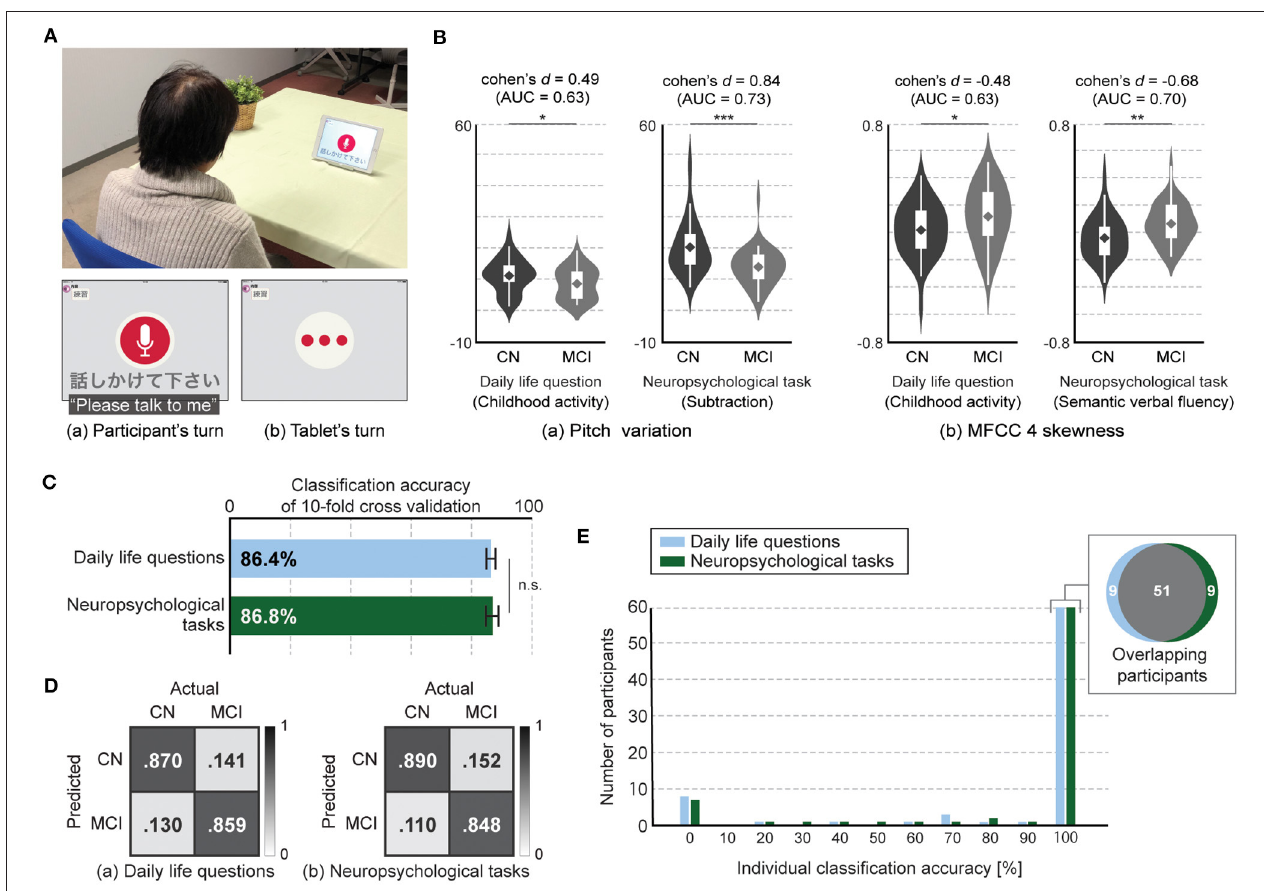
FIGURE 1 | Tablet-based assessment using speech responses to daily life questions and neuropsychological tasks. (A) Experiment setup and application interface. (B) Speech features with statistical significances between CN and MCI participants in both types, i.e., daily life questions and neuropsychological tasks, (two-tailed Student’s t -test with false discovery rate correction). Both speech features in responses to daily life questions had statistical significance but lower discriminative power between CN and MCI participants compared with those in responses to neuropsychological tasks. Significant differences are denoted with asterisks (* P < .05, ** P < .01, *** P < .001). Violin plot is used to visualize distribution of data and probability density. On each side of violin is kernel-density estimation to show distribution shape of data. Wider portion of violin indicates higher density and narrow region represents relatively lower density. White box with whiskers in violin is boxplot. Box denotes 25th (Q1) and 75th (Q3) percentiles. Whiskers denote upper and lower adjacent values that are most extreme within Q3+1.5(Q3-Q1) and Q1-1.5(Q3-Q1), respectively. Line and diamond in box represent median and mean, respectively. (C) Accuracy of classification models for differentiating MCI from CN participants using features extracted from speech responses to daily life questions and neuropsychological tasks. Error bar represents standard deviation for 20 iterations of 10-fold cross validation. (D) Confusion matrices of classification models for differentiating MCI from CN participants using features extracted from speech